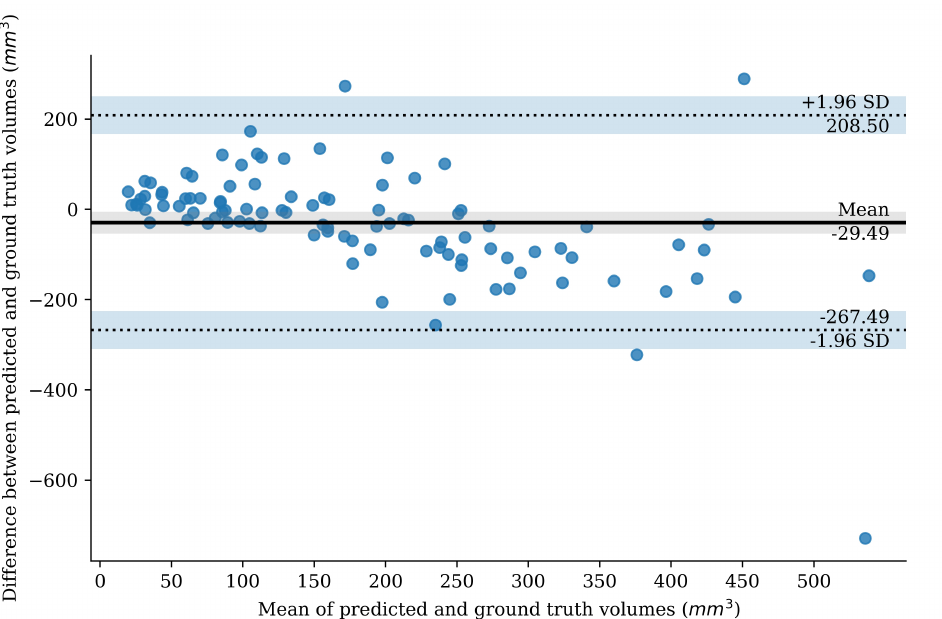
Figure 5. The 3D visualization of the NCCT scan. The segmentation prediction of the weighted-sum network is shown on a 2D slice of NCCT and CTA on top.